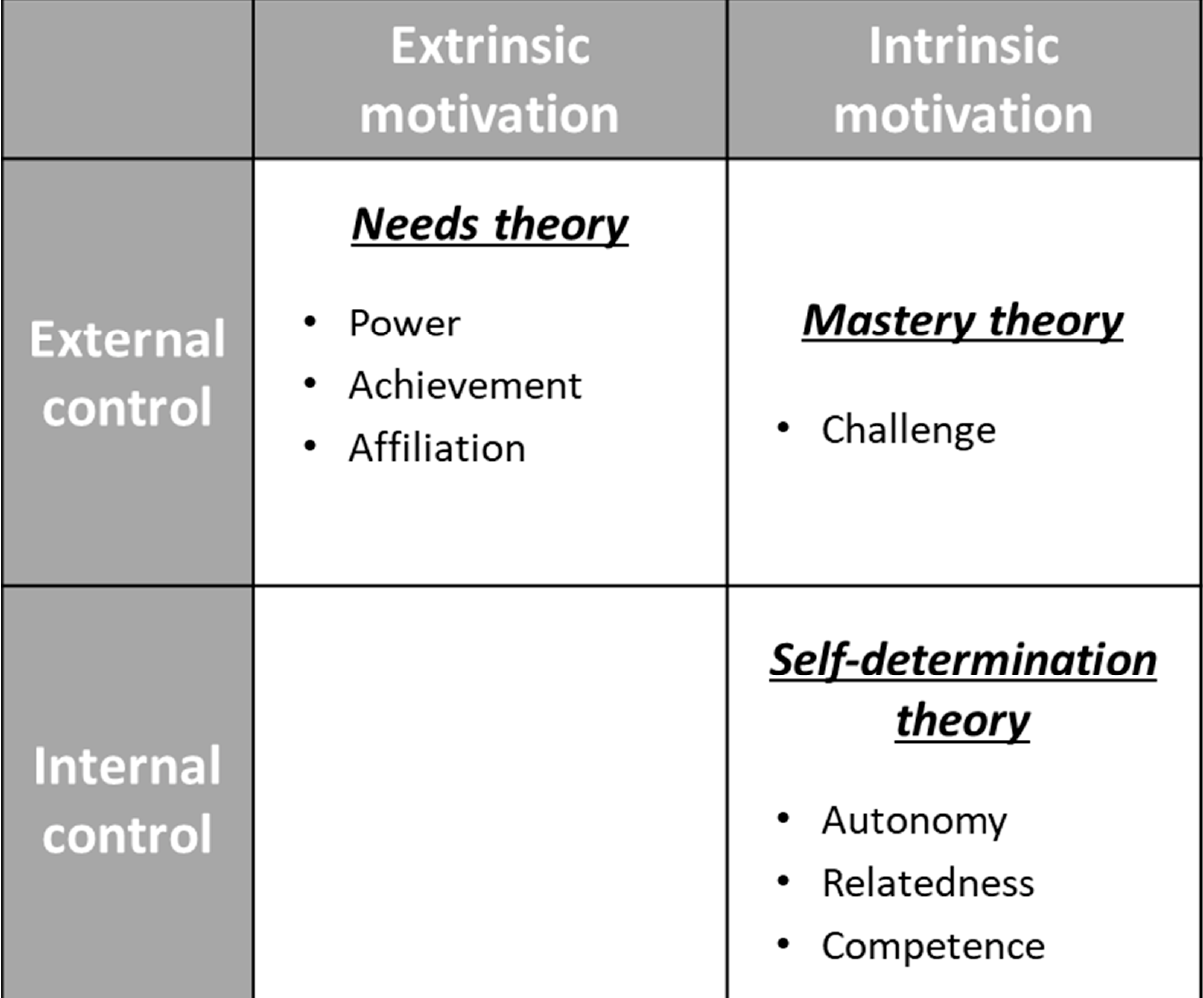
Figure 2. Model of job satisfaction in the COVID-19 pandemic.